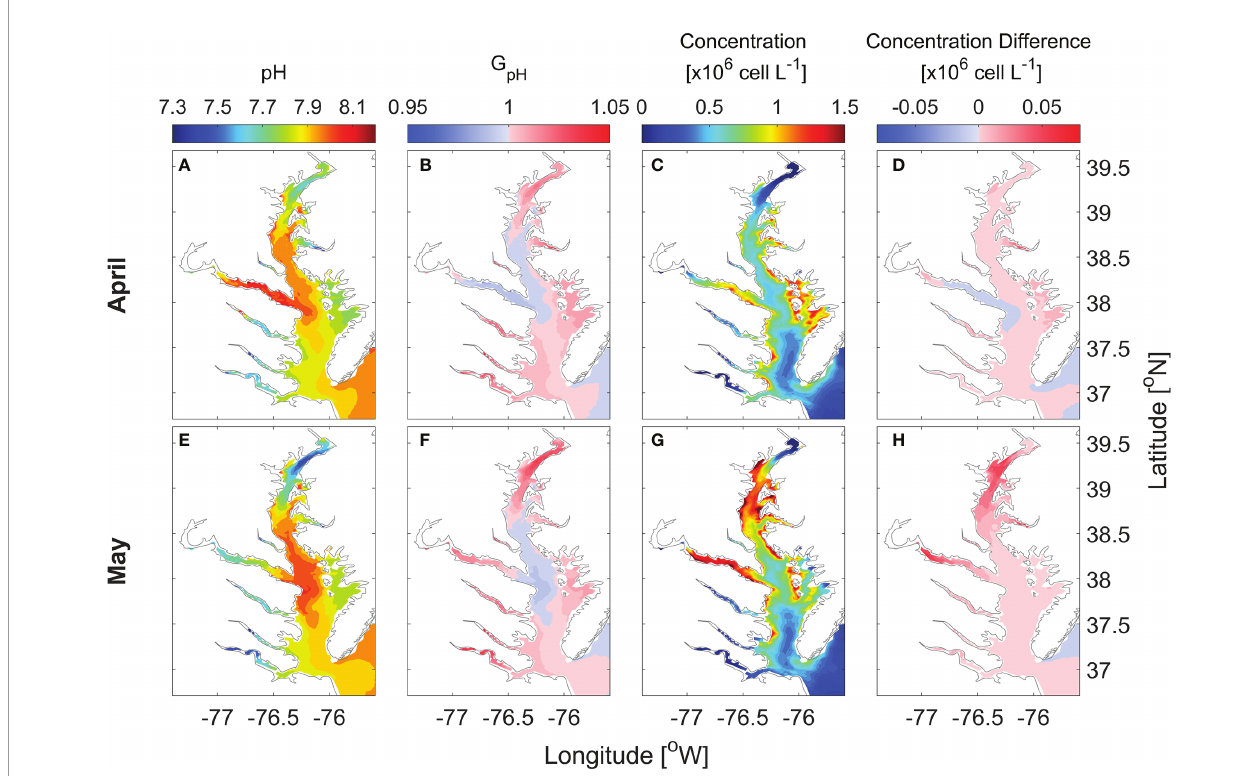
FIGURE 5 | Horizontal distribution of monthly-mean surface pH (A, E) , G pH (B, F) , P. minimum cell concentration (C, G) and the concentration difference between model with pH and without pH (D, H) in April and May when large blooms occurred in year